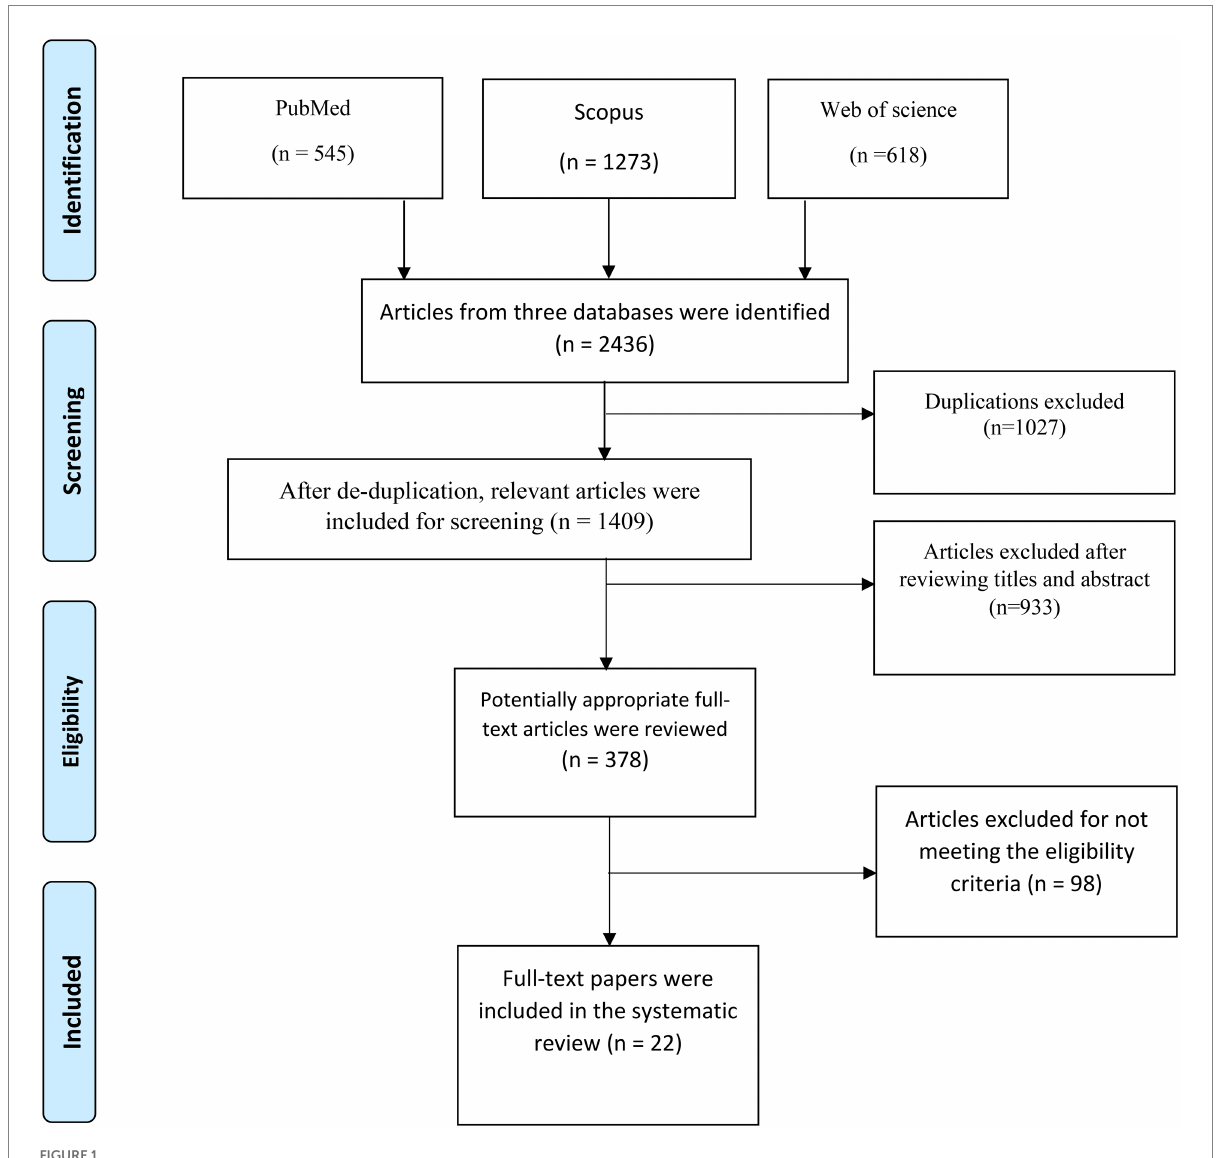
FIGURE 1 Flow chart of study selection